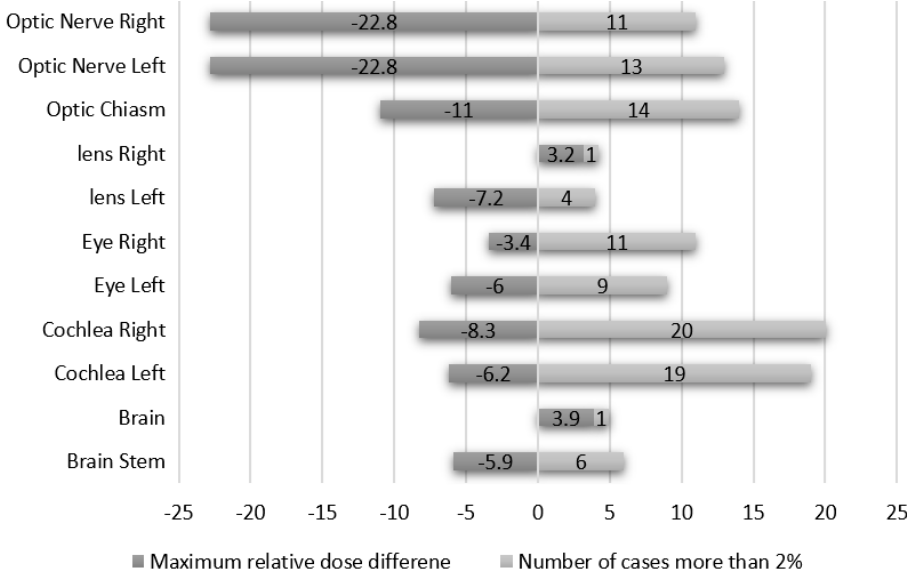
Figure 2. Maximum relative dose difference and number of patients with relative dose difference greater than 2% between NCCT and CCT for brain critical structures. The largest differences in small structures are attributed to registration accuracy.